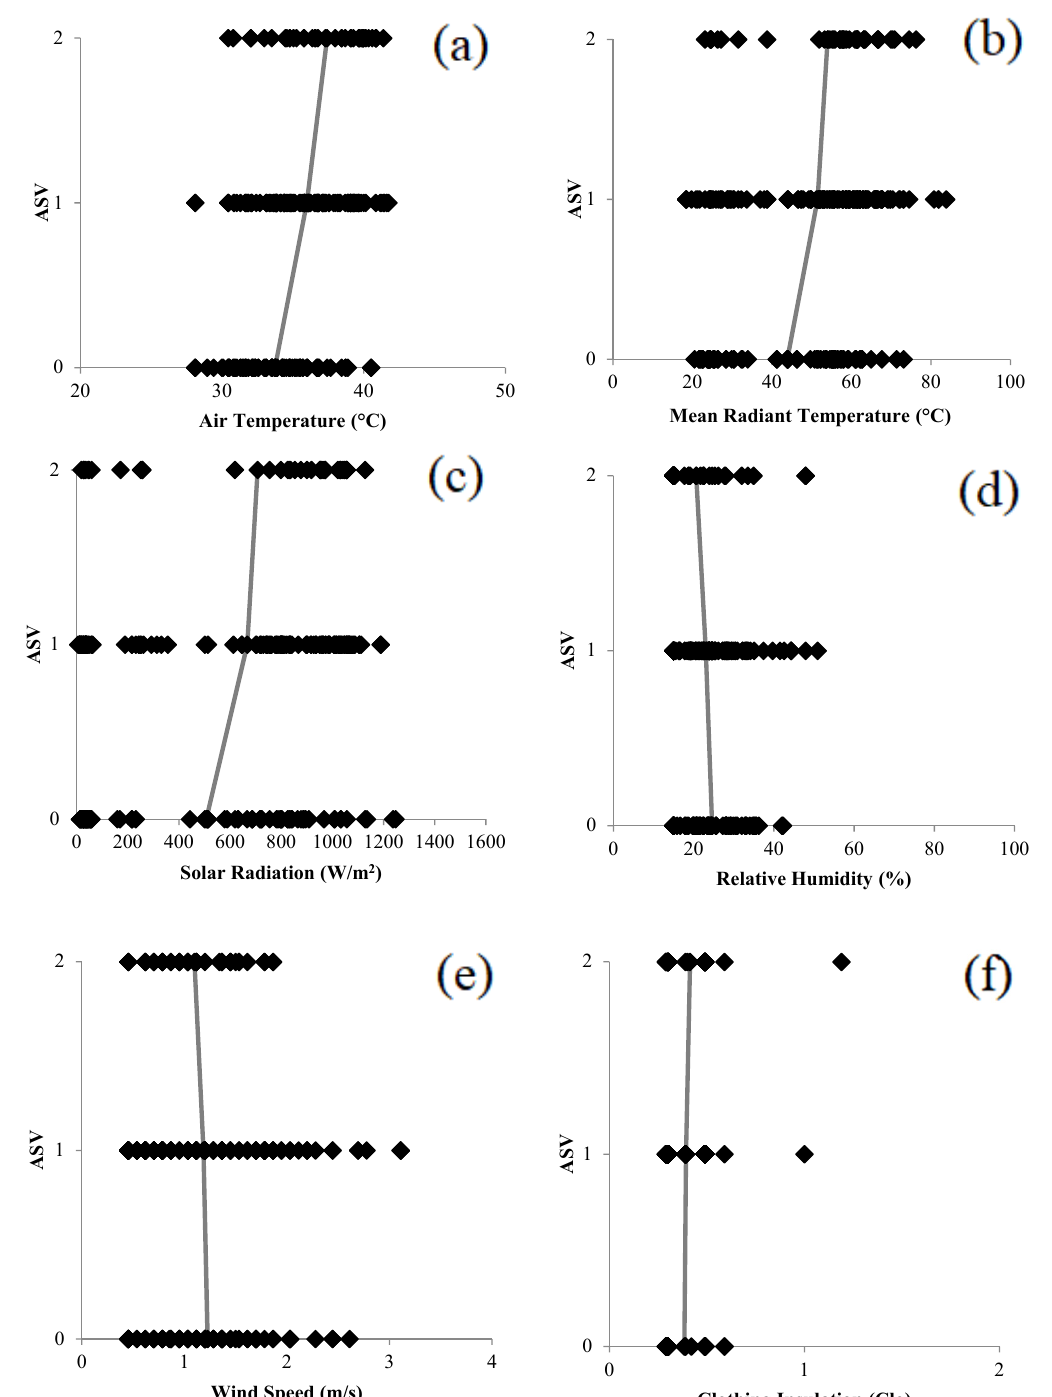
Figure 8. Weather parameters and clothing insulation per level of Actual Sensation Vote ( ASV ).